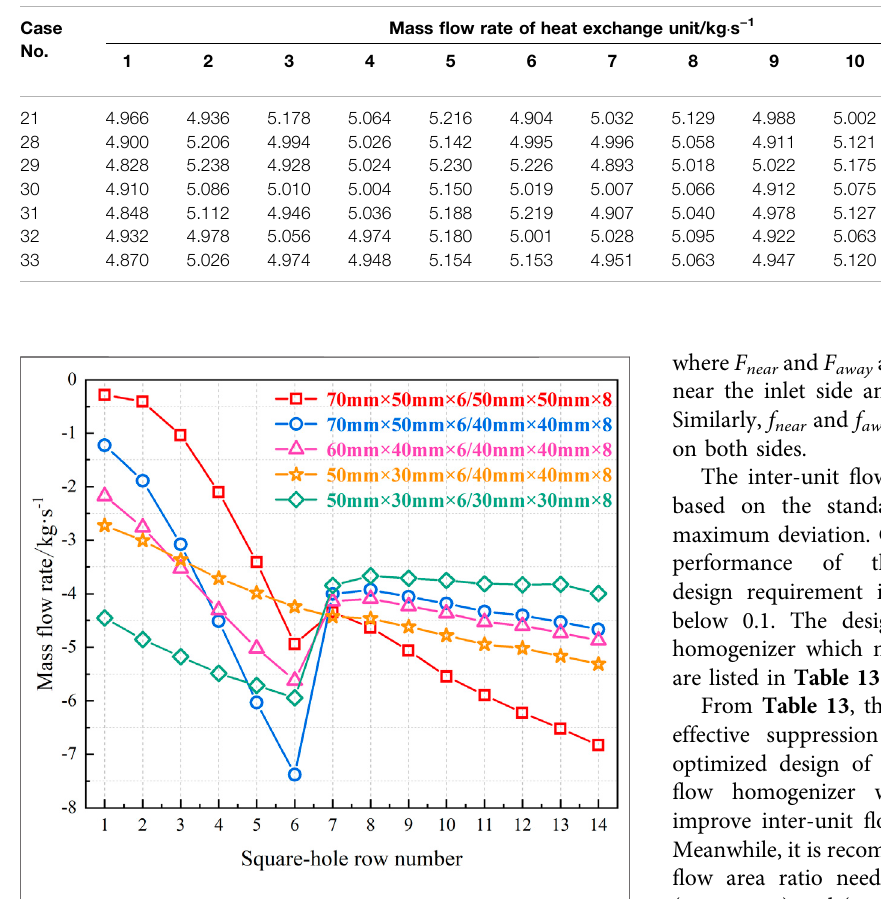
FIGURE 14 | Flow distribution characteristics of fl ow homogenizers with different square hole